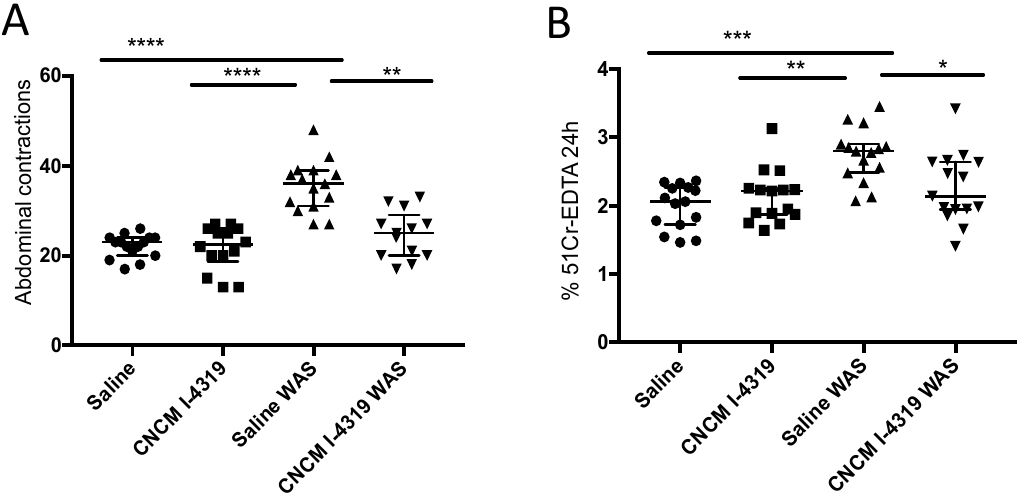
Figure 3. Visceral sensitivity and permeability measures in WAS model. Abdominal contractions in response to colorectal distension ( A ) and in vivo permeability measured by 51Cr-EDTA ( B ). Control no stressed (saline), control stressed (saline WAS), group no stressed treated with B. bifidum CNCM I-4319 strain (CNCM-I4319), group stressed treated with B. bifidum CNCM I-4319 strain (CNCM-I4319 WAS). *: p < 0.05; **: p < 0.01; ***: p < 0.001, ****: p < 0.0001.